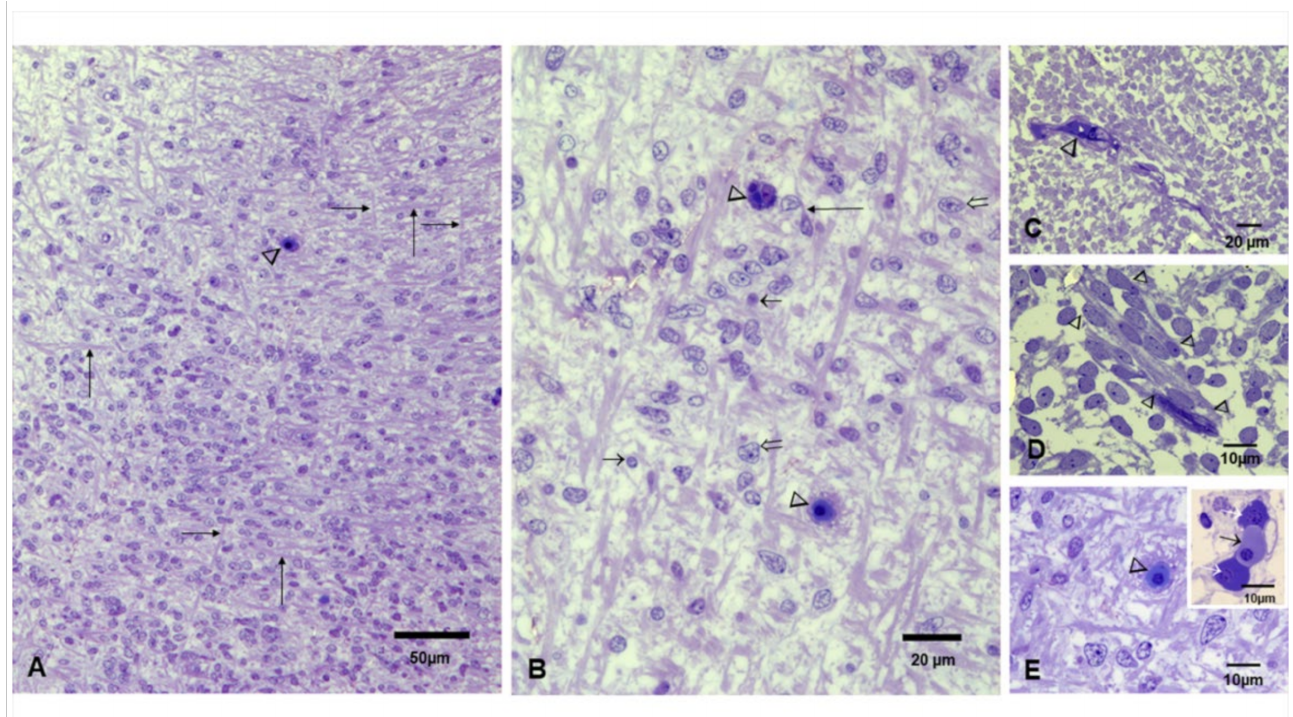
Figure 5. Brain toluidine blue sections, postconceptional weeks (PCW) 12–15. ( A ). Frontal region with a dominant radial organization, fibers in horizontal and vertical orientation (long arrows), and small blood vessels occupied by erythroblasts can be identified (arrowhead). ( B ). Close-up with fibers oriented in horizontal and vertical directions along cells with diverse nuclei shapes (short and open arrows) interspersed by cells with long processes (long arrow) and blood vessels occupied by erythroblasts (arrowheads). ( C ). Primitive glial cells can be identified along with small vessels (arrowhead). ( D ). Slender cells with long processes and vesicular nuclei streaming (arrowheads) in the primitive cortex. ( E ). Neuronal bodies and numerous capillaries with luminal erythroblasts areidentified. Insert shows three erythroblasts in different stages of development; the orthochromatic cell is marked with a short black arrow between two basophilic cells marked with white